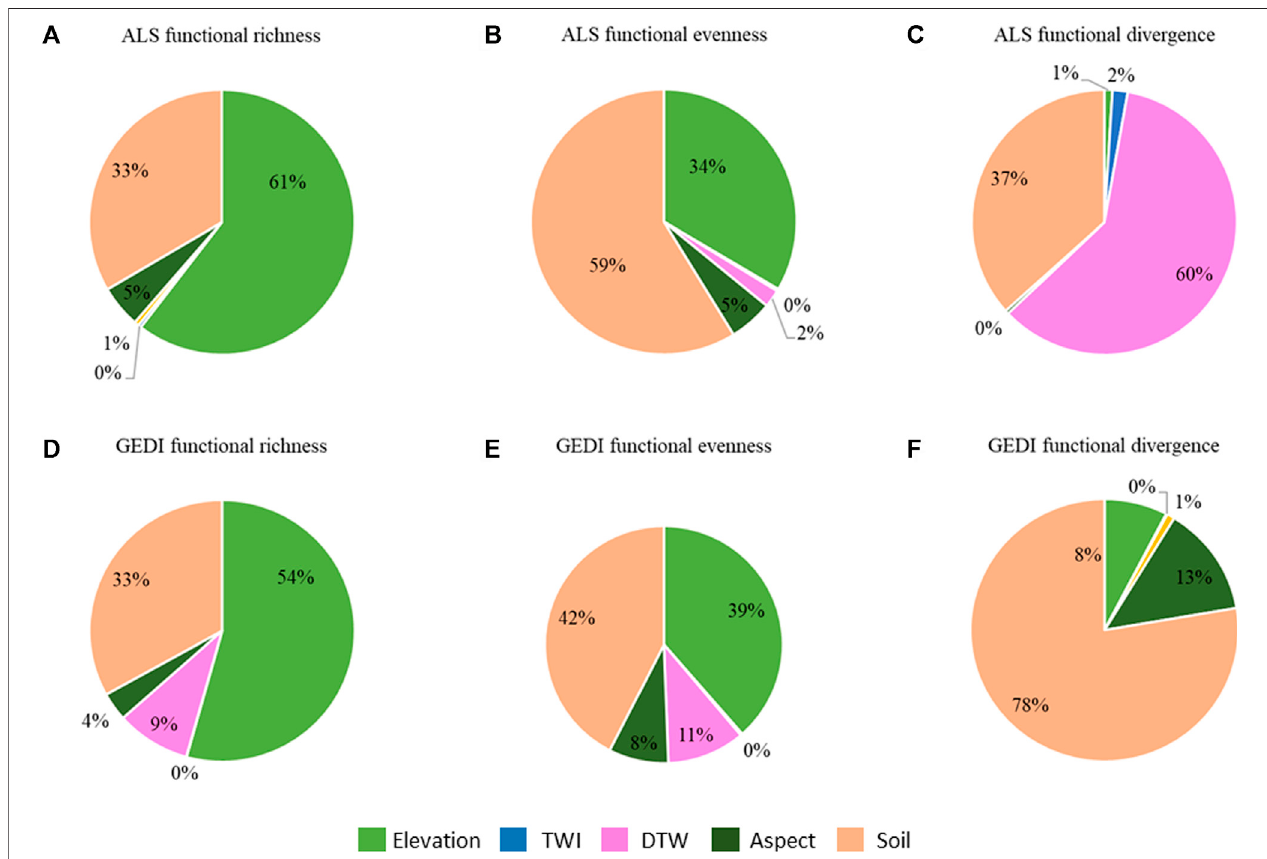
FIGURE10| Relativeimportanceofeachabioticfactorfromgeneralizedlinearmodelsthatexplainthevariabilityofdiversityindices.Diversityindicesestimatedfrom ALS (A – C) and derived from GEDI (D – F) .